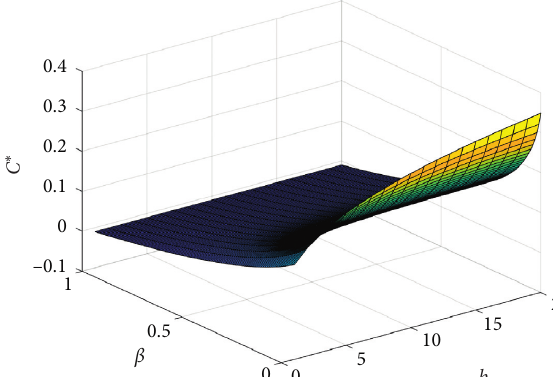
Figure 13: Effect of risk level β and retail price p on the optimal inventory cost C ∗ under RMI mode with stochastic demand in the water supply chain.